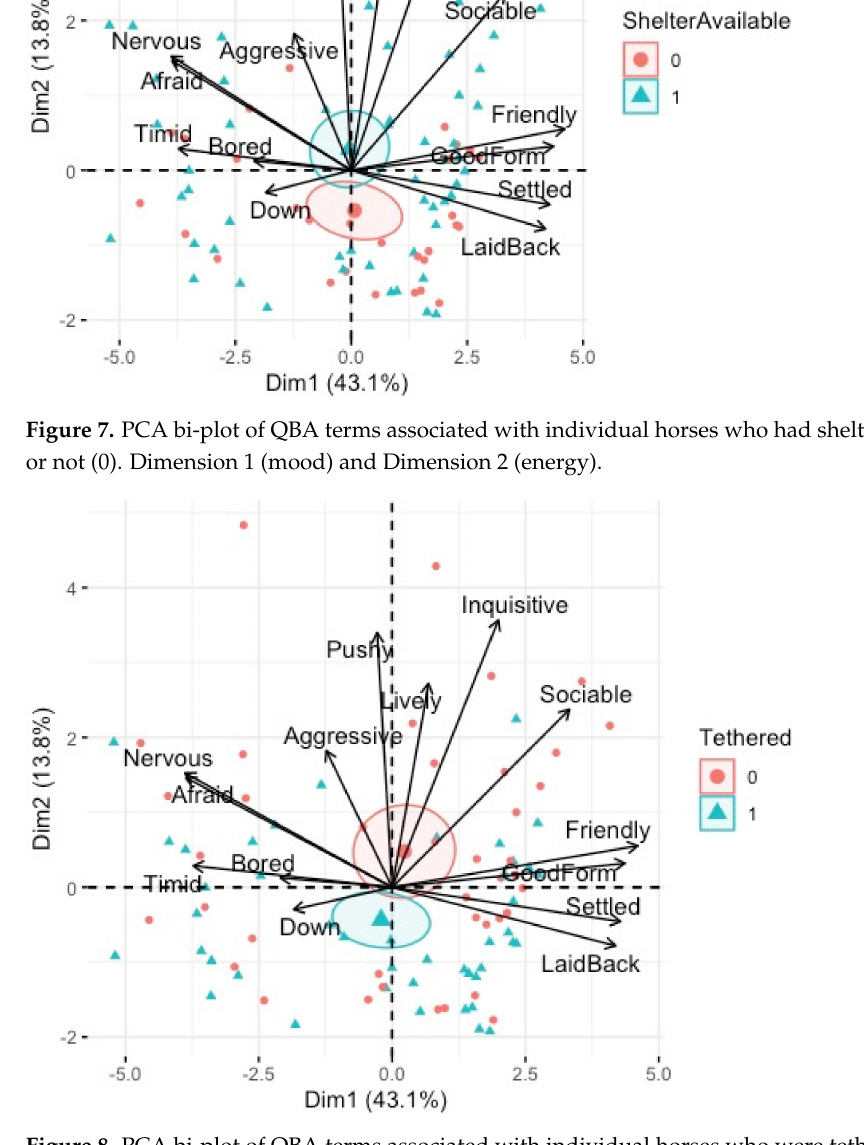
Figure 8. PCA bi-plot of QBA terms associated with individual horses who were tethered (1) or not (0). Dimension 1 (mood) and Dimension 2